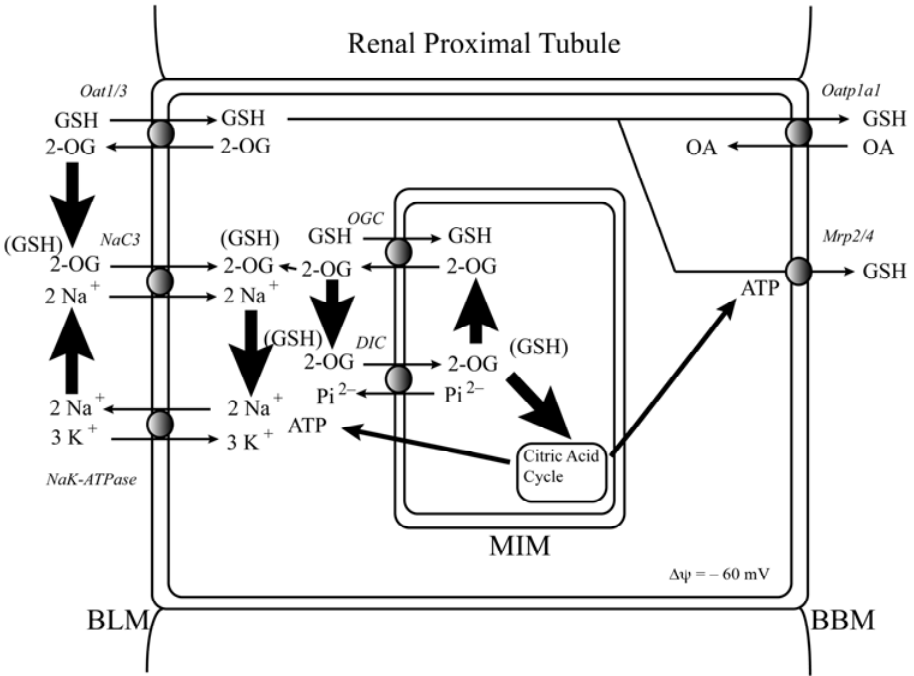
Figure 5. Pathways of glutathione transport in renal proximal tubular cells. Shown